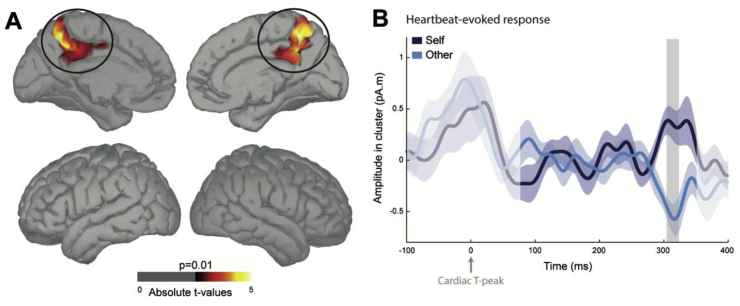
Neural sources of the Heartbeat-Evoked Response (HER) effects. A, HER differences between Self and Other were localized in the anterior precuneus and posterior cingulate cortex bilaterally (left: Monte-Carlo p = 0.022; right: Monte-Carlo p = 0.016; threshold for visualization: >30 contiguous vertices at uncorrected p < 0.010). B, Time course of the HERs (±SEM) in the region in A. The signal that might be residually contaminated by the cardiac artefact appears in lighter color. The grey area represents the time window in which a significant difference was observed at the sensor level.